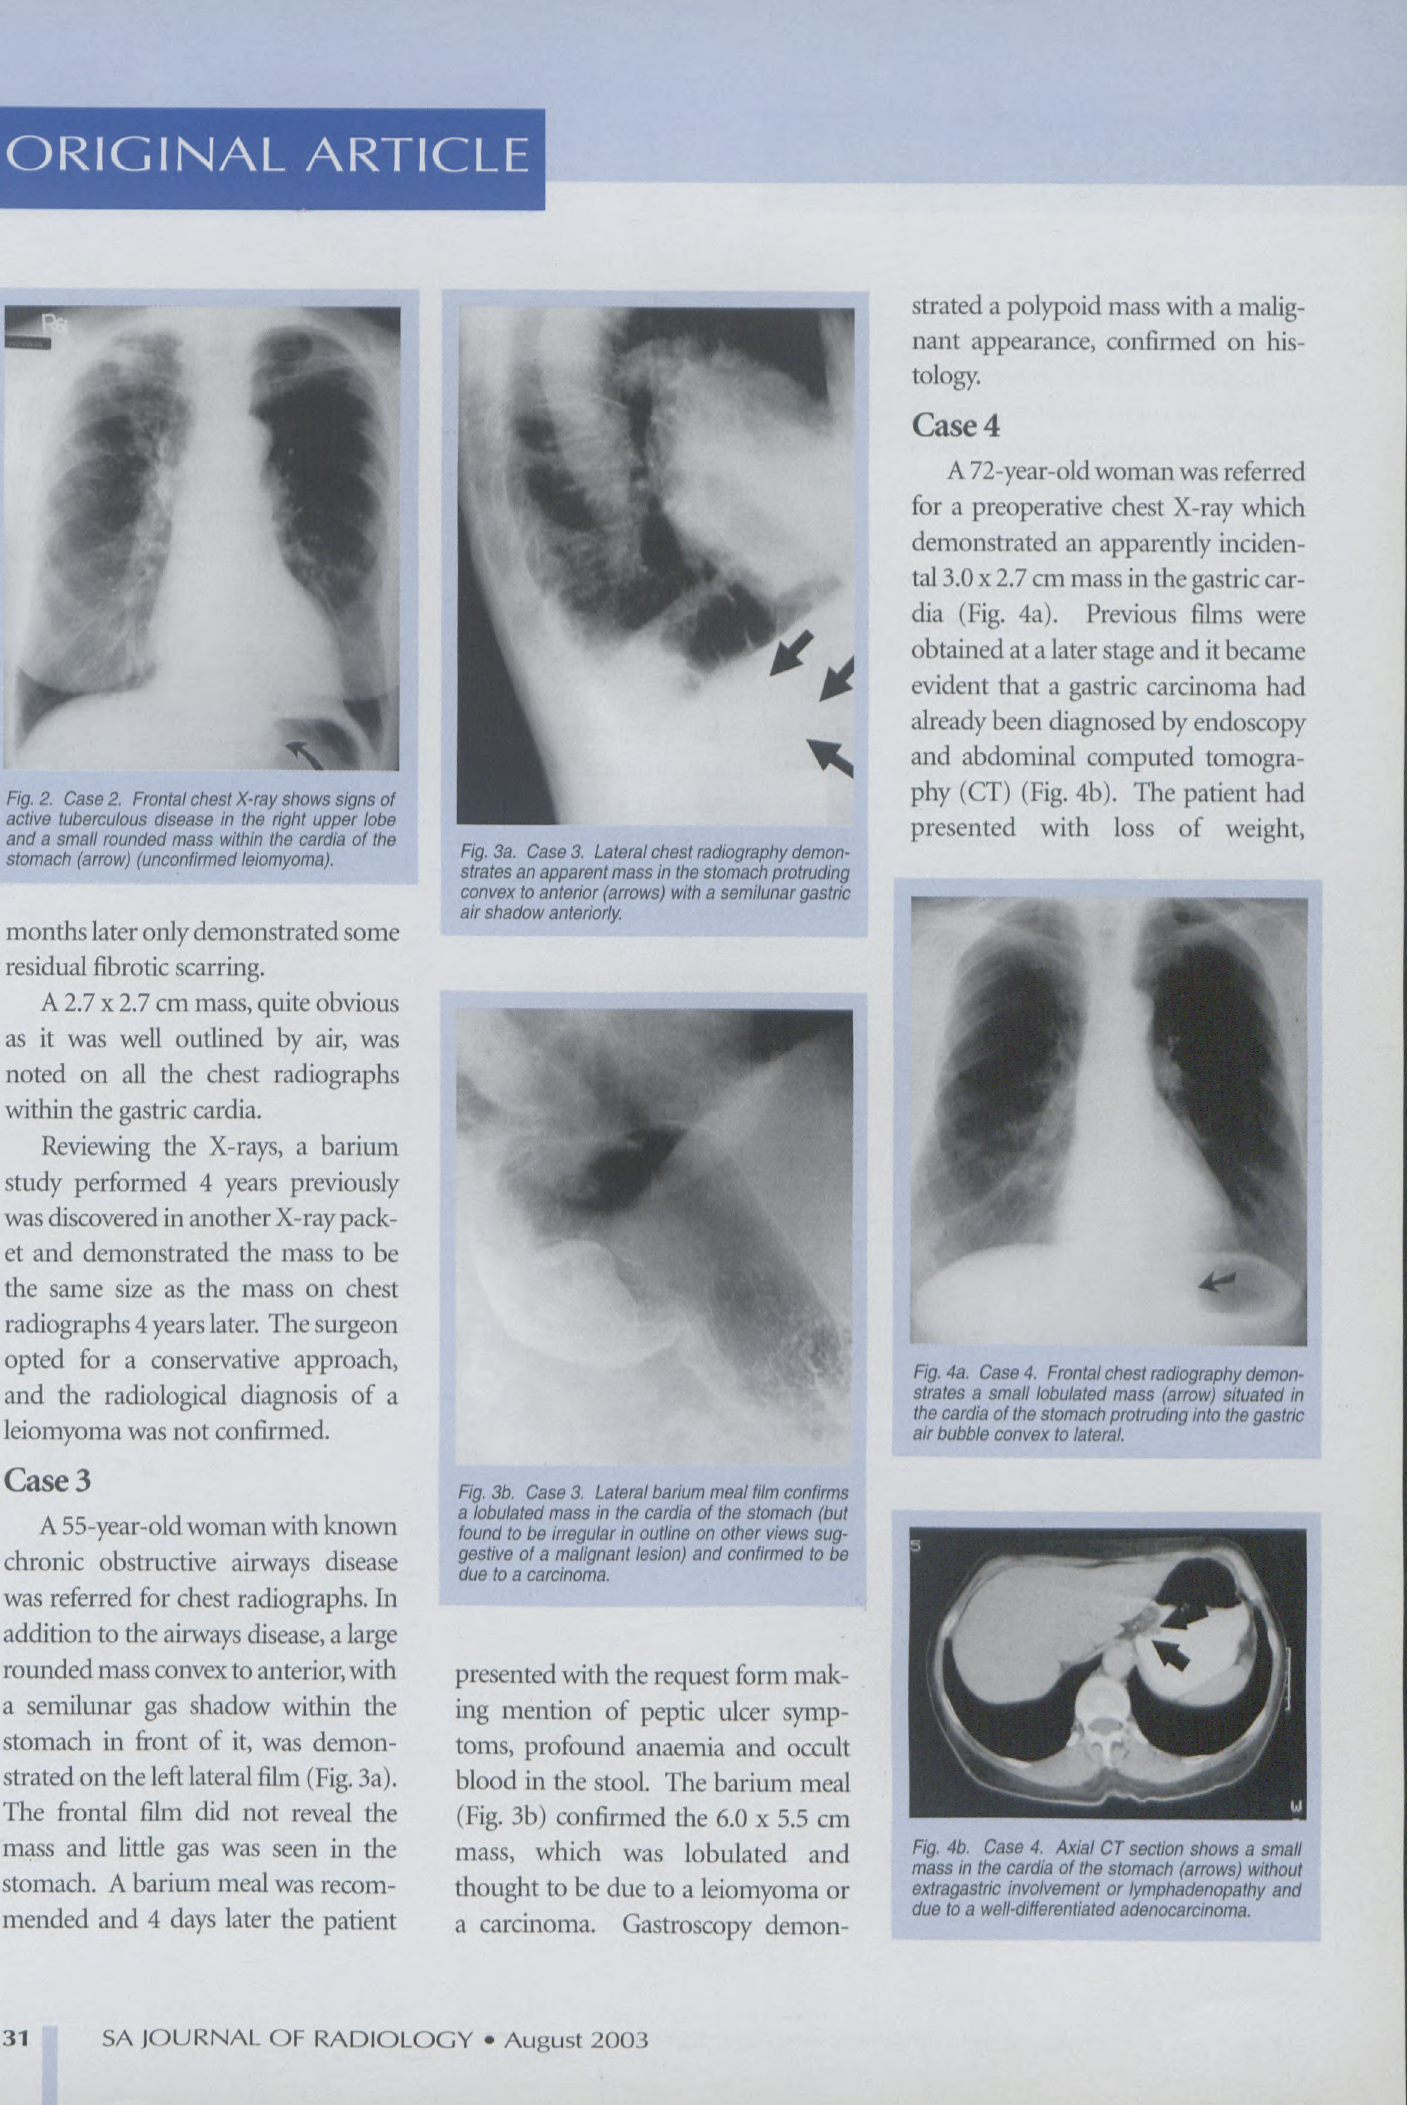
Fig. 3b. Case 3. Lateral barium meal film confirms a lobulated mass in the cardia of the stomach (but found to be Irregular in outline on other views sug- gestive of a malignant lesion) and confirmed to be due to a carcinoma.